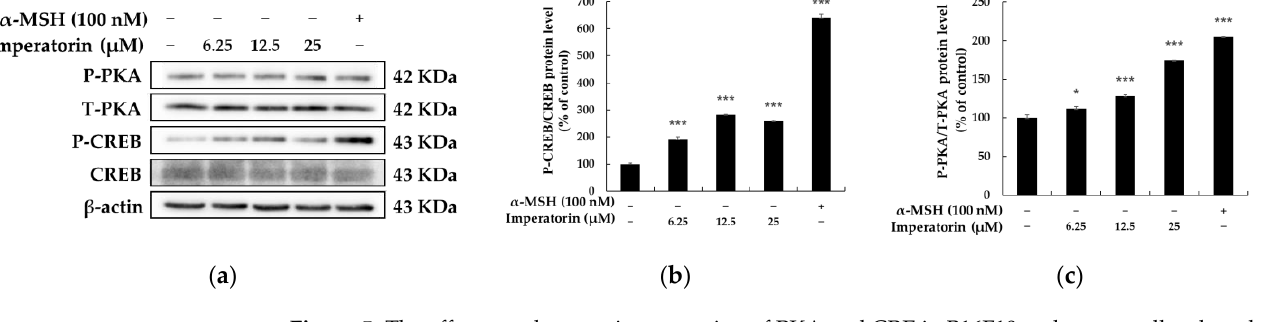
Figure 5. The effects on the protein expression of PKA and CRE in B16F10 melanoma cells when the cells were treated with imperatorin (25, 12.5 and 6.25 μM) for 15 min: ( a ) Western blotting results; protein levels of ( b ) P-CRE and ( c ) P-PKA. β -Actin was used as a loading control. The results are presented as the mean ± SD from three independent measurements using ImageJ software. * p < 0.05, and *** p < 0.001 vs. the untreated control group.